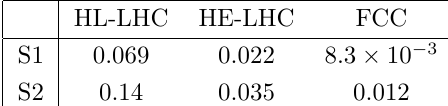
spectra, these signals are almost invisible as they produce small missing energy and very soft leptons or jets. For de(cid:12)niteness, we can quantify this statement for the masses and mixing angles used in the previous benchmarks, cf. (5.1), (5.2) in three representative